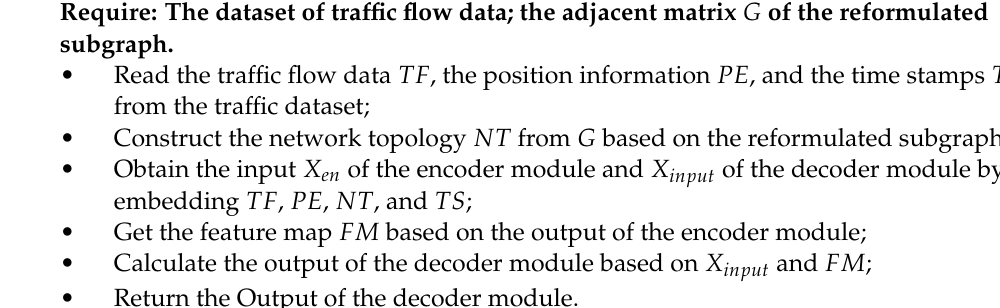
Algorithm 2 Spatio-temporal deep learning